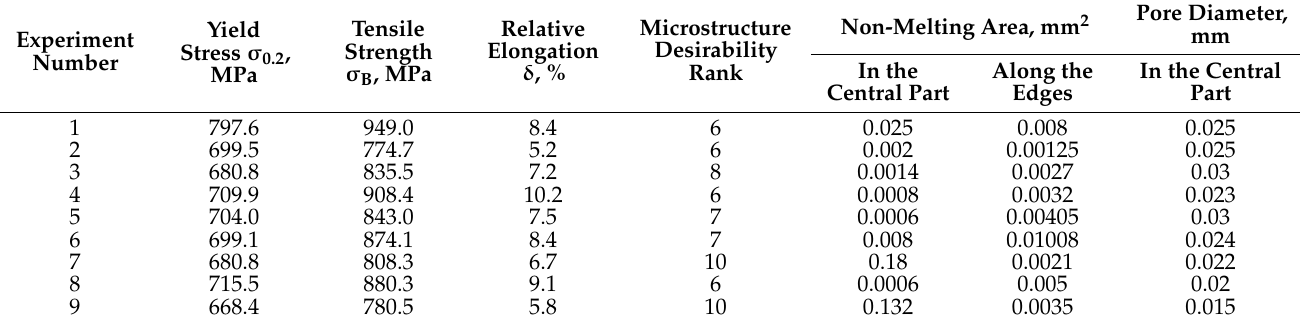
Table 5. Experimental